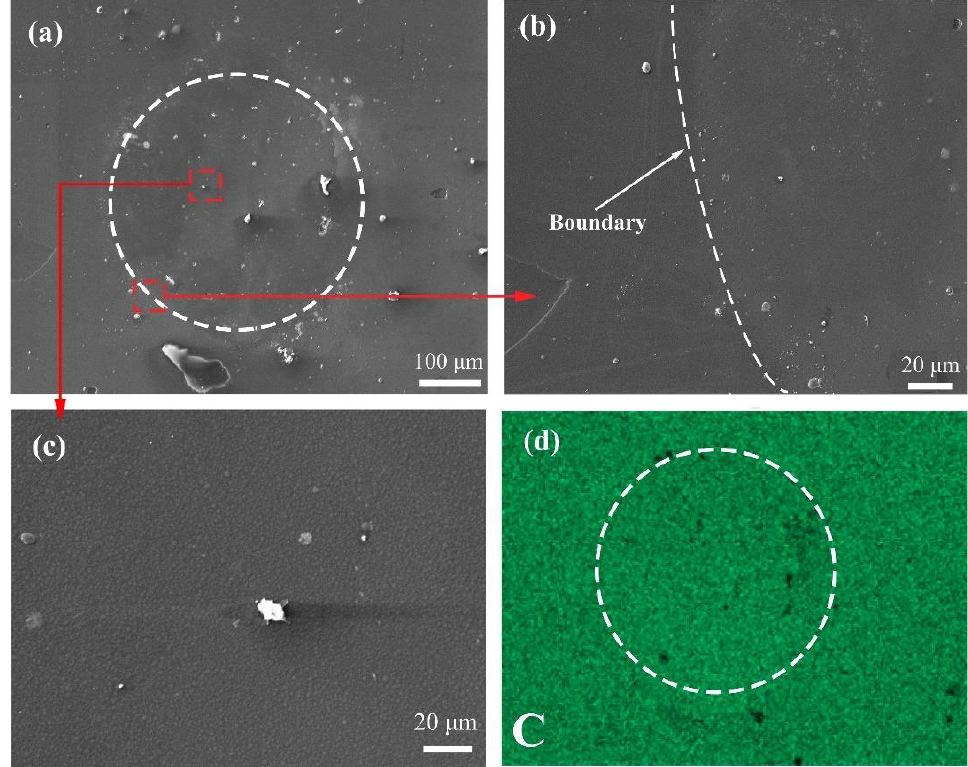
Figure 8. Wear scar topography and elemental distribution of Cr/W-DLC/DLC multilayer films at RT under no sand condition: ( a – c ) wear scar topography; ( d ) elemental distribution.